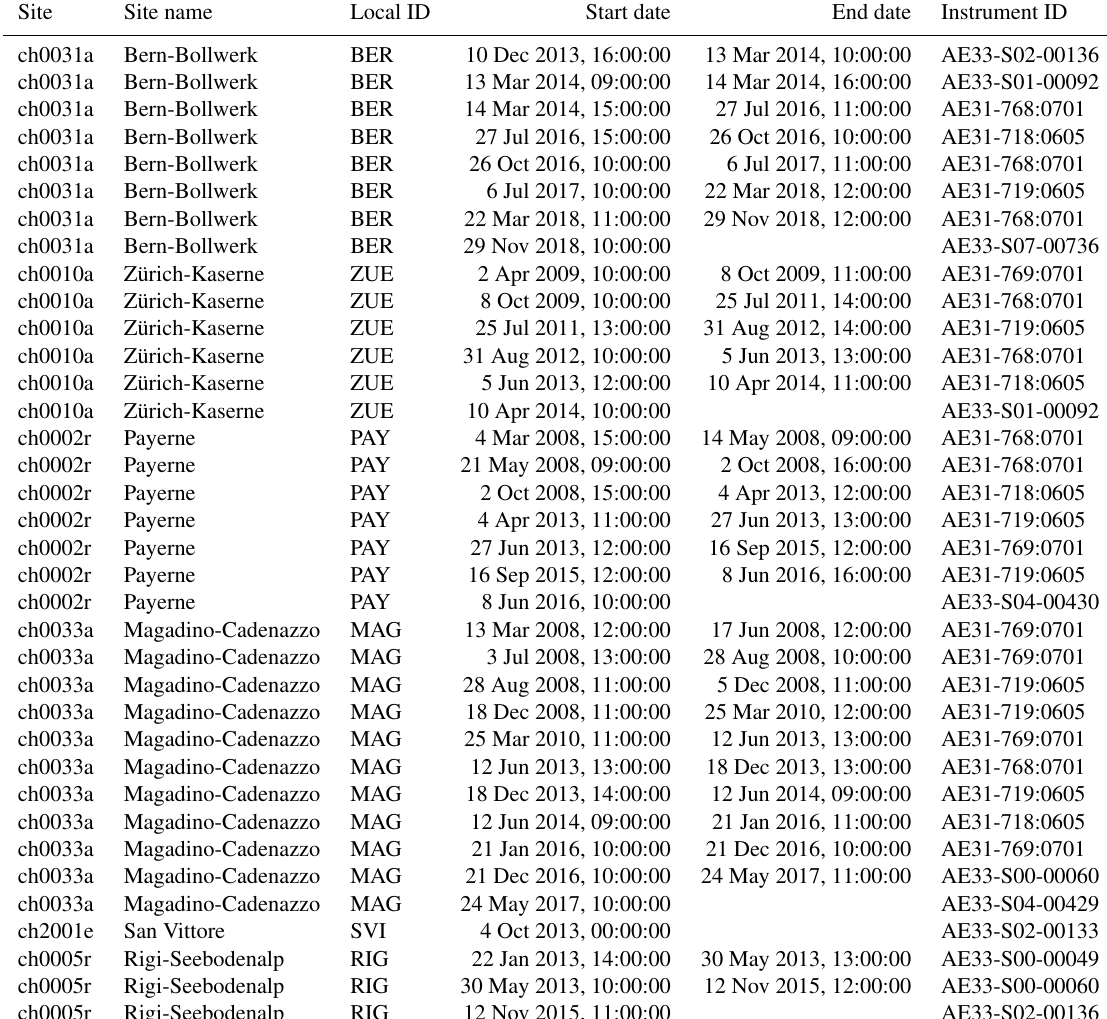
Table 2. Aethalometer instruments’ locations between 2007 and 2018. Dates have been rounded to the nearest hour, and those end dates which are missing show that the instrument was on site until the end of the analysis period (the end of